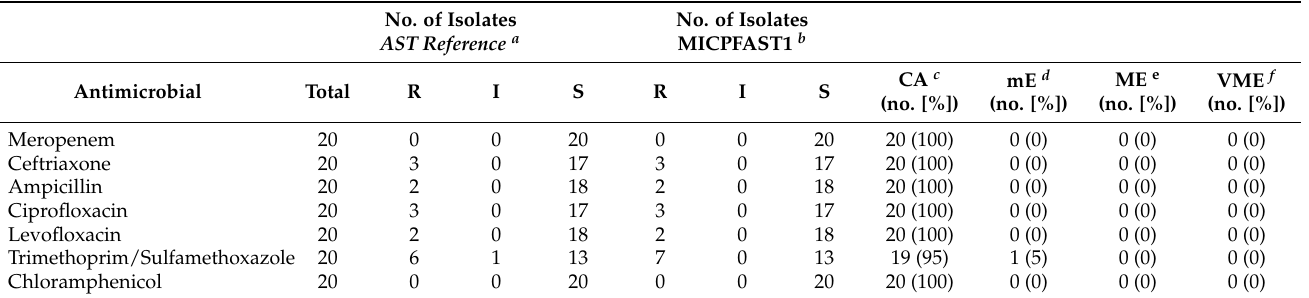
susceptible, increased exposure; S, susceptible; c CA, categorical agreement; d mE, minor error; e ME, major error; f VME, very major error.